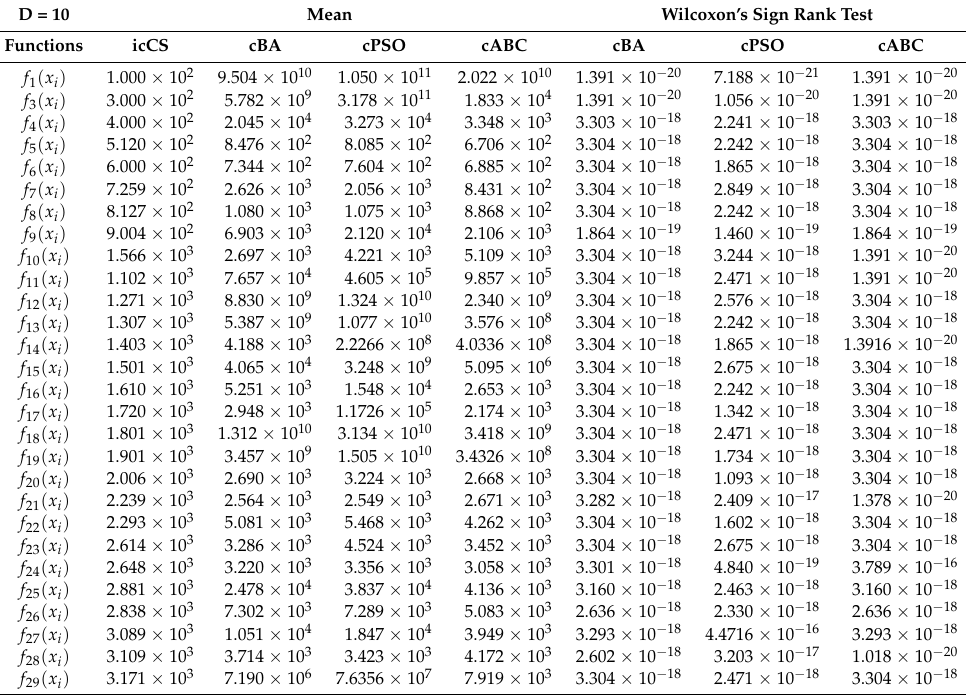
Table 5. Comparison with the average fitness function on 10D optimization among cBA, cPSO, and cABC algorithms on 28 test functions. The overall performance of each of the other algorithms was measured at a significant level α = 0.05 under the Wilcoxon’s signed rank test.